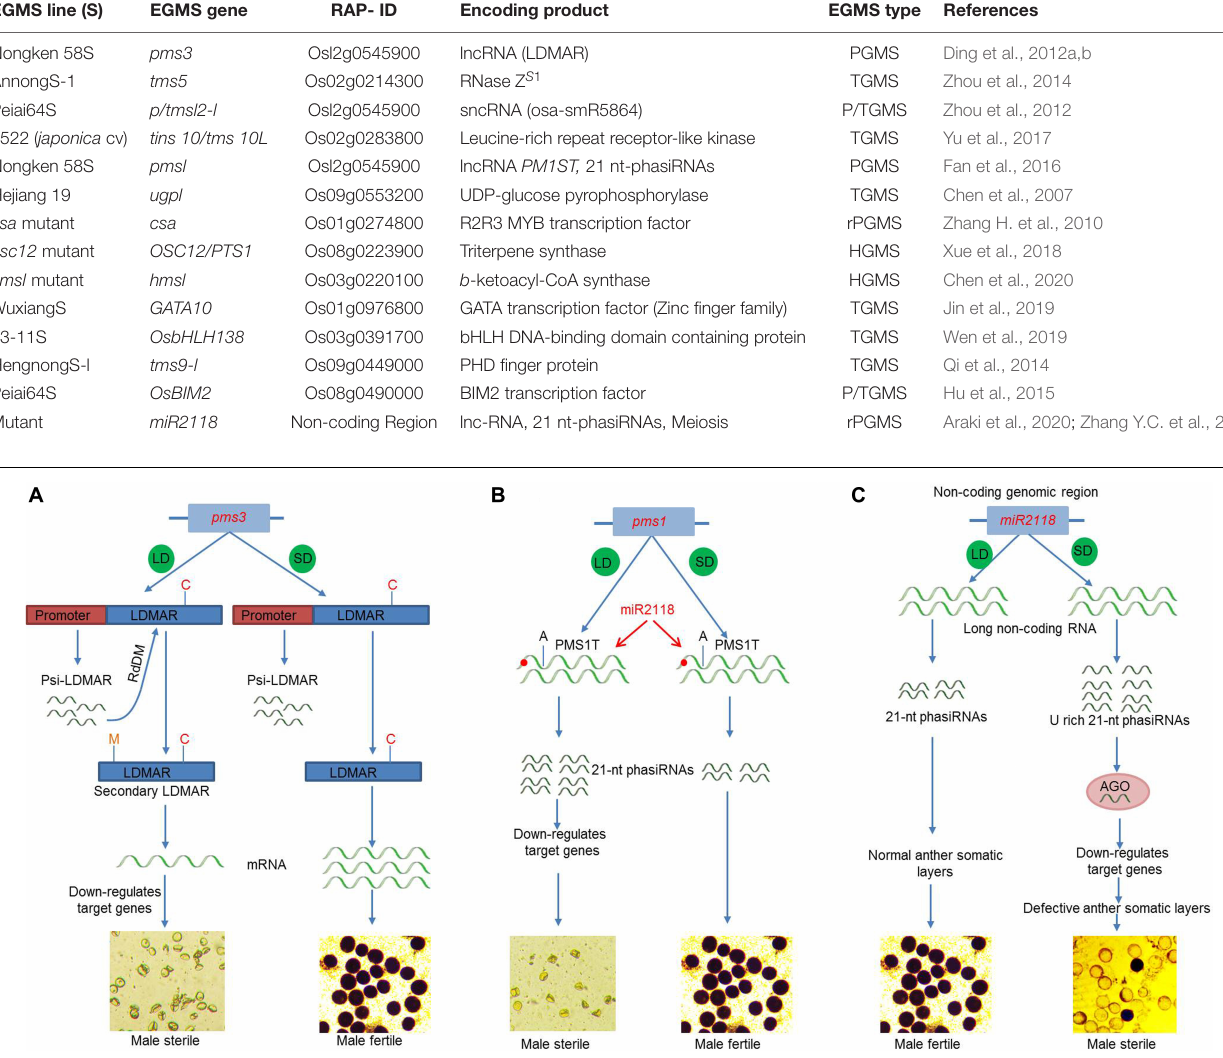
FIGURE 2 | Molecular mechanism of fertility–sterility transition of environment-sensitive genic male sterility (EGMS) genes. (A) pms3 encodes a non-coding RNA long-day-specific male-fertility-associated RNA (LDMAR). The promoter generated psi-LDMAR follows RdDM pathway and increases DNA methylation of single-nucleotide polymorphism (SNP) carrying LDMAR resulting in secondary LDMAR structure, reduced transcript production, and male sterility under long-day (LD) conditions. While under short-day (SD) conditions, SNP does not affect transcript production and produces fertile pollen. (B) pms1 encodes a long non-coding RNA PMS1T. An SNP in the promoter of PMS1T affects the binding of miR2118 and produces higher level of 21-nt phased small-interfering RNAs (phasiRNAs), which then downregulates the target genes and cause male sterility under long-day (LD) condition. (C) miR2118 produces excess of U-rich 21-nt phasiRNAs, which, in coordination with AGO proteins, downregulates target genes and causes male sterility under SD conditions. Under LD conditions, fertility is restored. C, SNP; M, methylation; LD, long day; SG, short day; HT, high temperature; LT, low temperature; RdDM, RNA-directed DNA methylation; AGO,